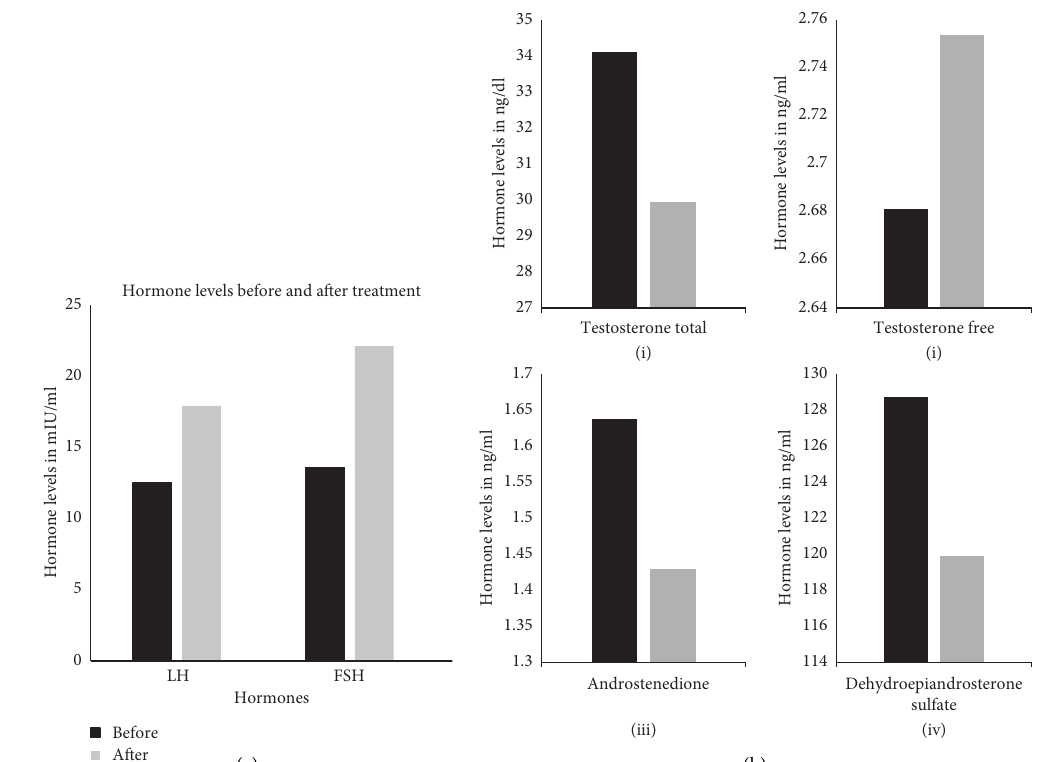
Figure 7: Variation in hormone levels before and after treatment with Tracnil ™ . The different hormone levels at week 0 (black bar) and at week 24 (grey bar) are presented as average ± SEM. (a) analyzes LH and FSH levels. (b) compares testosterone total and free levels (i and ii) and androstenedione and dehydroepiandrosterone sulfate levels (iii and iv). Statistical analysis using Student’s t -test ( P > 0 . 05) was used to assess any significant changes in levels. Table 3: The endocrine and metabolic assessment of patients before (week 0) and after (week 24) the treatment with Tracnil ™ . Group LH ∗ (mIU/ml) FSH ∗ (mIU/ml) LH/FSH ∗ ratio Before 12.51 ± 2.29 13.61 ± 4.84 1.692 ± 0.223 After 17.91 ± 3.17 22.13 ± 5.73 1.393 ± 0.217